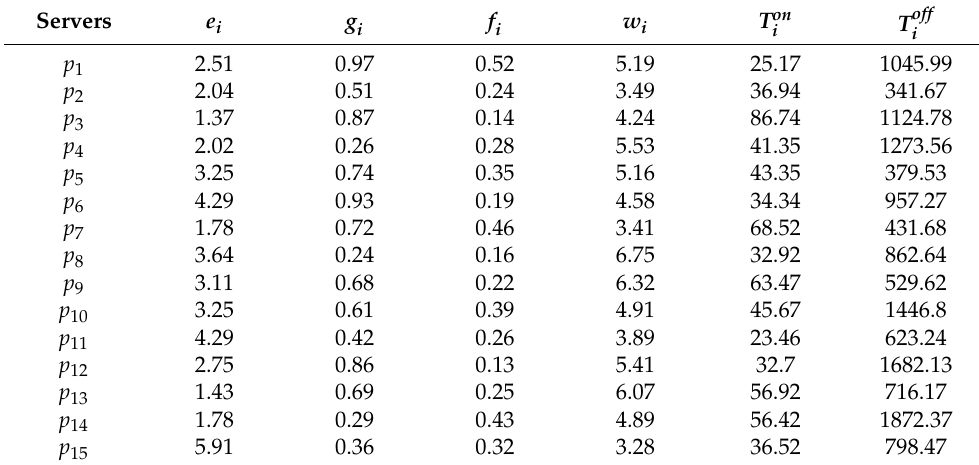
Table 2. Parameters of the heterogeneous networked system.